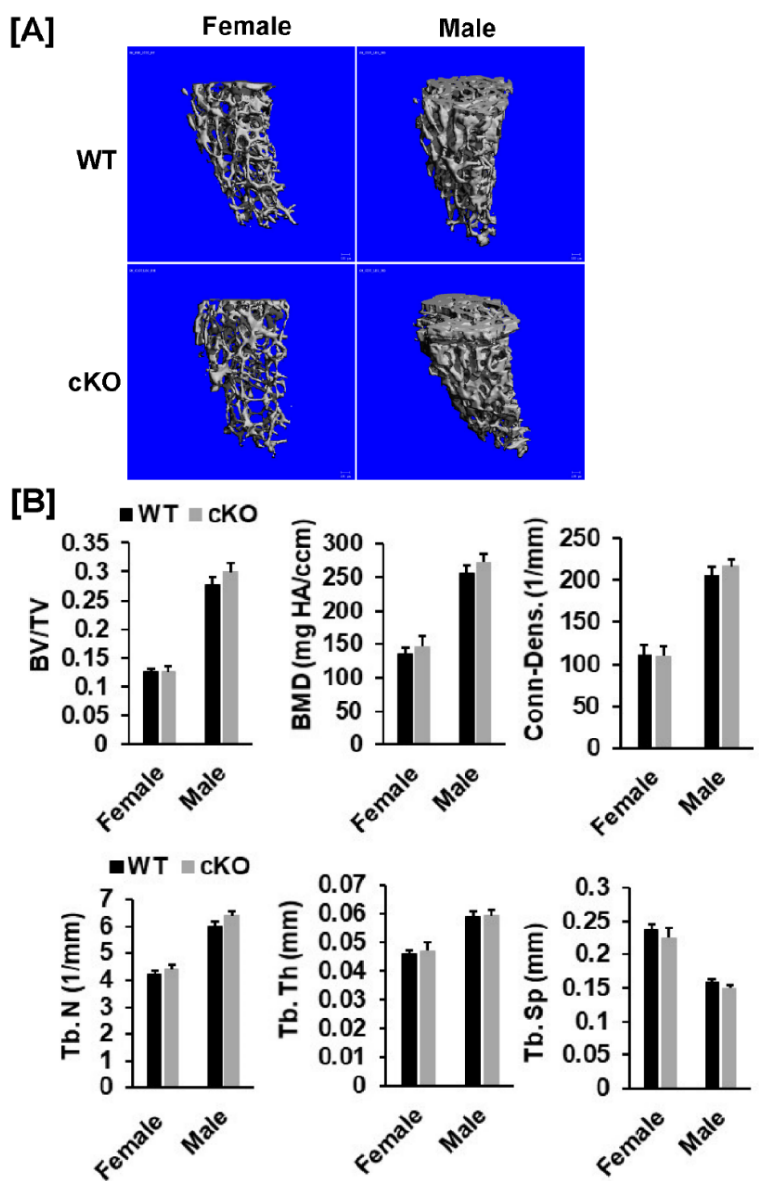
Figure 3. Micro-CT analysis revealed no changes in trabecular parameters of the femur of the Phd3 cKO mice at 16 weeks of age. ( A ): Micro-CT images of the trabecular bone of the distal. ( B ): Quantitative data of trabecular parameters of the femur (BV/TV, BMD, Conn-Dens., Tb. N, Tb. Th, and Tb. Sp).